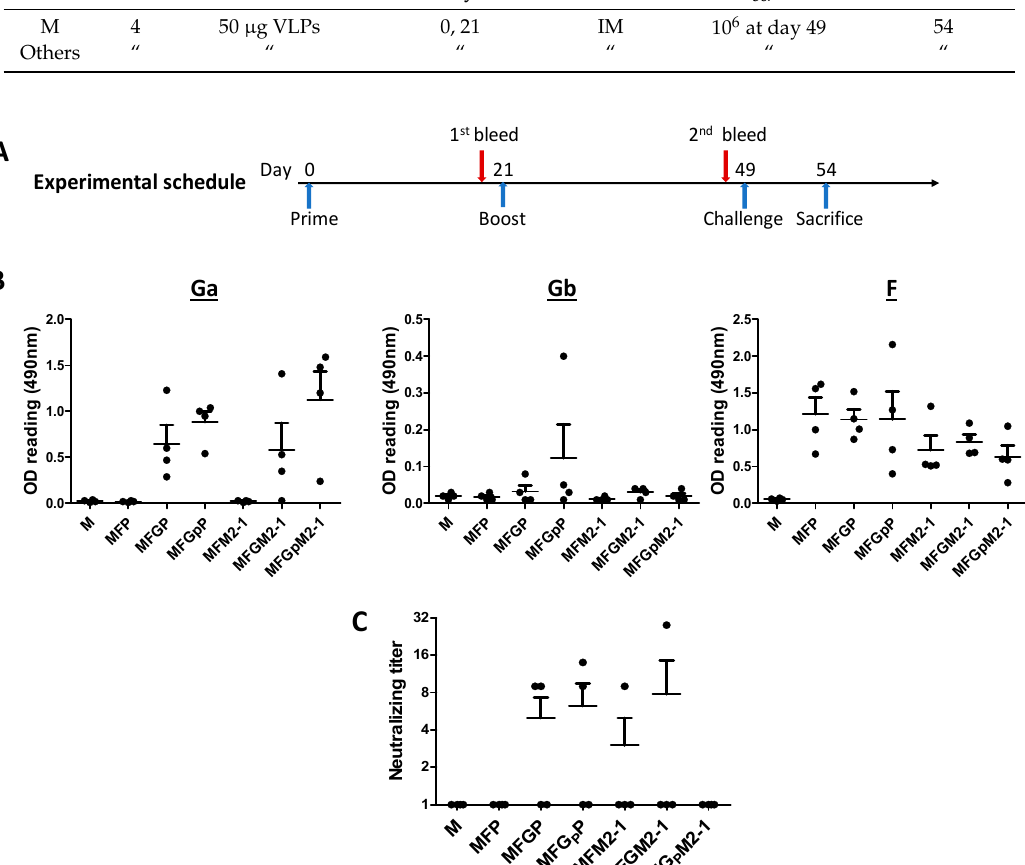
Figure 4. VLP-immunized mice generate serum antibodies against G and / or F. ( A ) Schematic schedule of animal experiments. ( B ) Sera from immunized animals (diluted 1:200) were tested by ELISA for Ga, Gb, or F protein-binding antibodies. After blocking, plates were incubated with goat anti mouse IgG-HRP secondary antibody. OPD substrate was used to develop reaction and absorbance at 490 nm was read. Note the VLPs efficiently induced antibodies against Ga and F but not Gb. ( C ) Sera from immunized animals were heat inactivated at 56 °C for 30 min followed by two-fold serial dilution in triplicate. The dilutions were incubated with 100 TCID 50 of RSV A2 virus for 1h at RT. The mixtures were then transferred to monolayer HEp-2 cell and incubated for 1 h at 37 °C in 5% CO 2 . 5% FBS + MEM media was added to the cells followed by incubation for 72 h at 37 °C in 5% CO 2 . Cells were fixed and ELISA was performed using goat anti-RSV antibody and HPR-conjugated donkey anti-goat secondary antibody. Reaction was developed by OPD and absorbance read at 490 nm. Neutralizing titers were calculated using Reed–Muench method. Note low levels of neutralizing antibodies were induced by the VLPs.